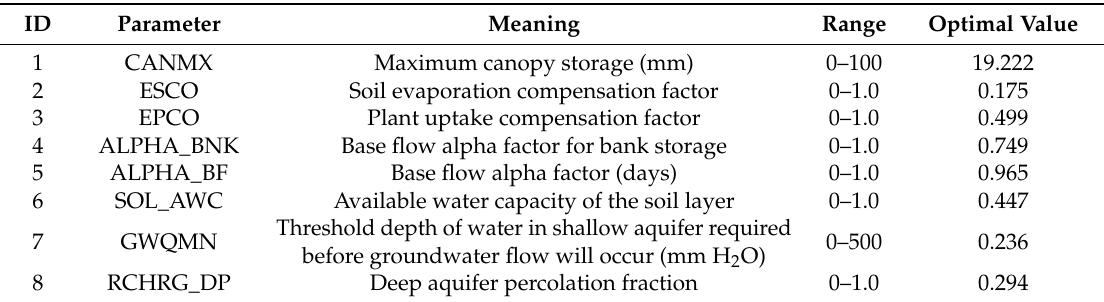
Table 1. Calibrated parameters of Soil and Water Assessment Tool (SWAT) model and their optimal